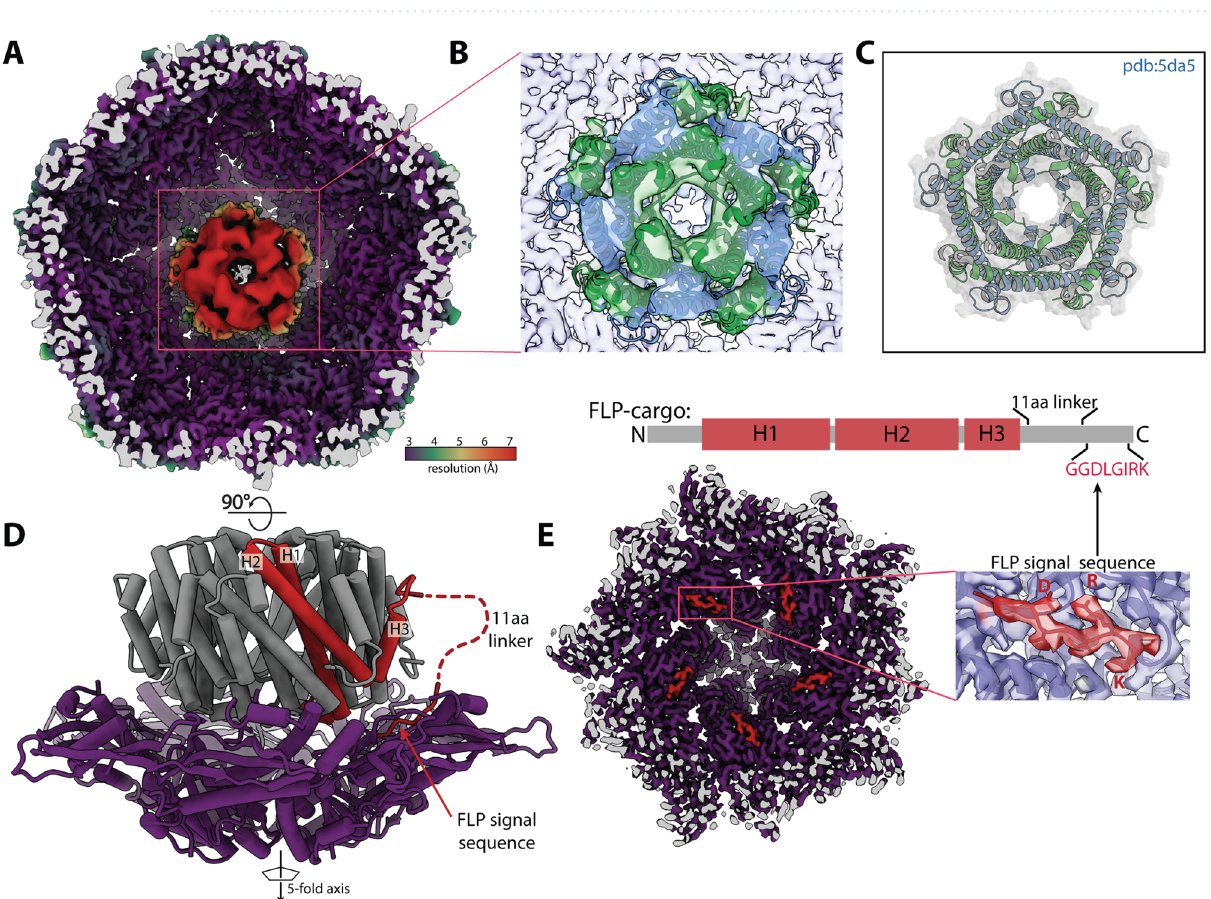
Figure 4. The fivefold FLP cargo sits on the fivefold axis of encapsulin. ( A ) Cryo-EM map resulting from symmetry expansion and focused classification, colored by local resolution, with the shell at ~ 3.5 Å resolution and the FLP cargo at ~ 7 Å . ( B ) Unambiguous docking of a known FLP decamer structure (PDB:5da5), with the crystal structure shown by itself in ( C ). The alternating blue and green coloring are for visualizing the distinct pentamer units of the FLP cargo. ( D ) is a 90° rotation and the atomic model for the map shown in ( A ). This structure shows how the FLP sits at the fivefold axis as well as the flexible linker that connects the body of the FLP protein to the C-terminal 8 residue signal sequence that connects the FLP to the encapsulin shell ( E ), confirming what had been identified in previous studies 4